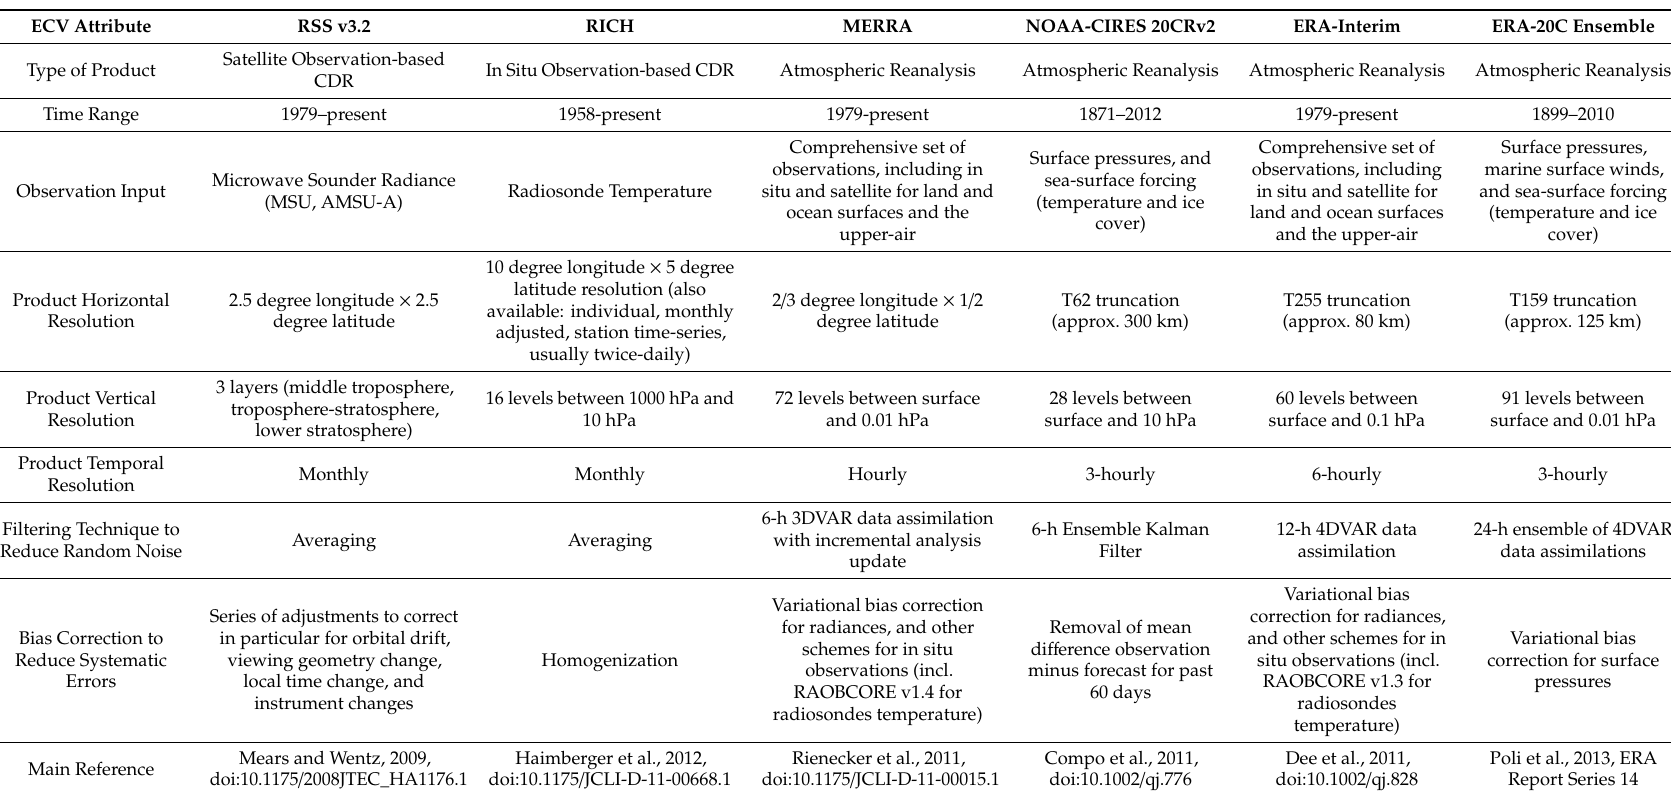
Table 1. Example of “descriptive product comparison” for a selection of upper-air temperature products from multiple sources [58] (see Appendix A for acronyms, T–Truncation in “spectral models” that use spherical